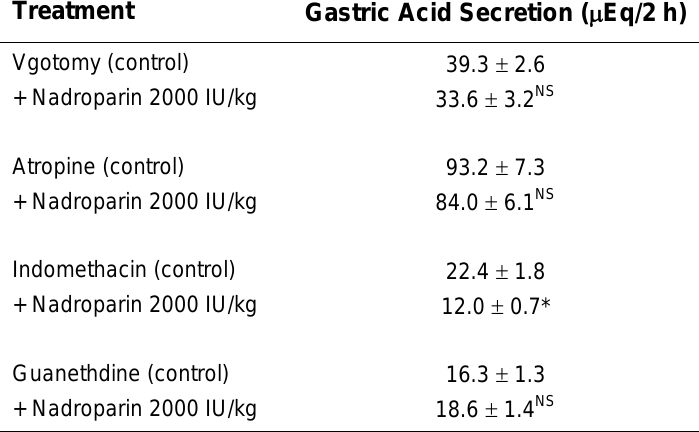
Data represent mean ± SEM of 2-h collection of gastric acid secretion. The control group was treated with vehicle (saline). n = 6/group. NS: not significant vs. corresponding control group. * p < 0.001 vs. indomethacin control group. Student ’ s t